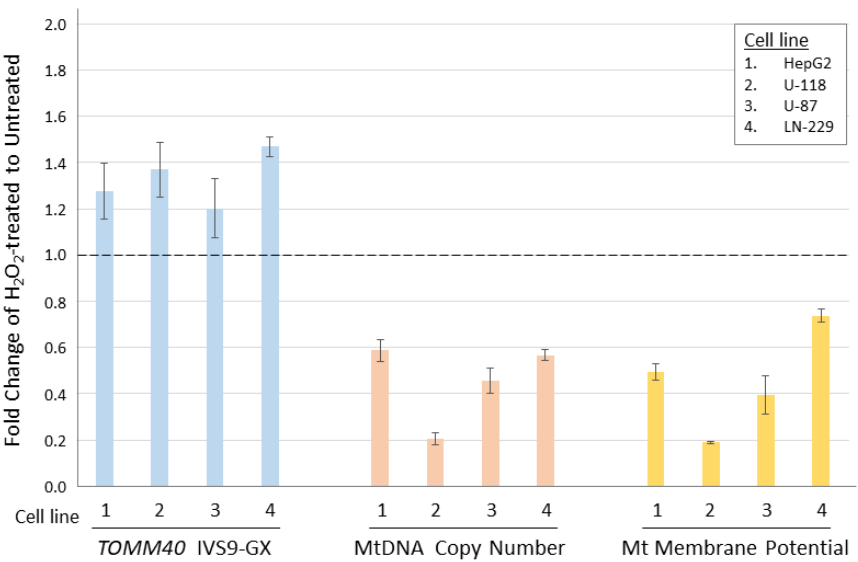
Figure 6. Comparison of TOMM40 RNA levels with mitochondrial functions in human cell lines. TOMM40 RNA levels were measured by the IVS9 assay and mitochondrial function assays including MtDNA copy number and Mt membrane potential were performed. The fold change of H 2 O 2 -treated cells was compared to the untreated cells (set as baseline of 1.0). Graph shows the relationship between the three measurements in response to the oxidative stress. Standard deviation error bars are shown.